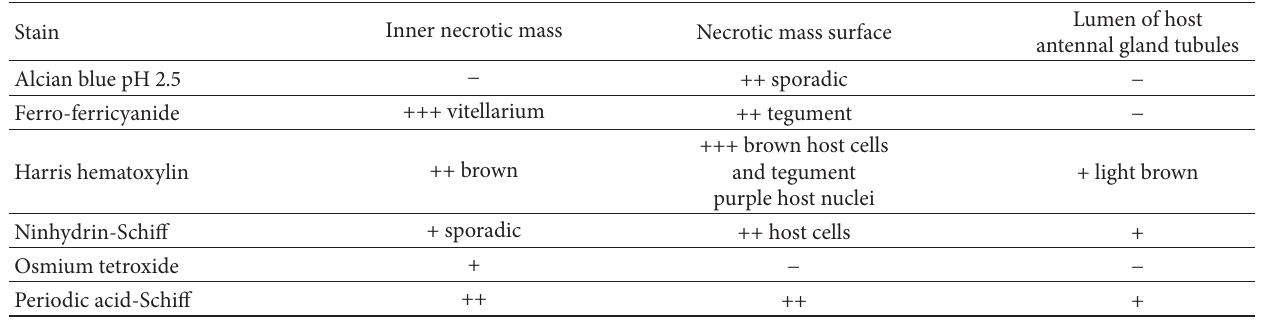
Table 4: Necrotic Alloglossidium renale tissue staining